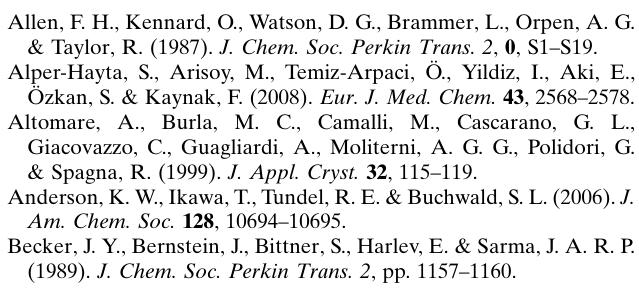
Crystal data Chemical